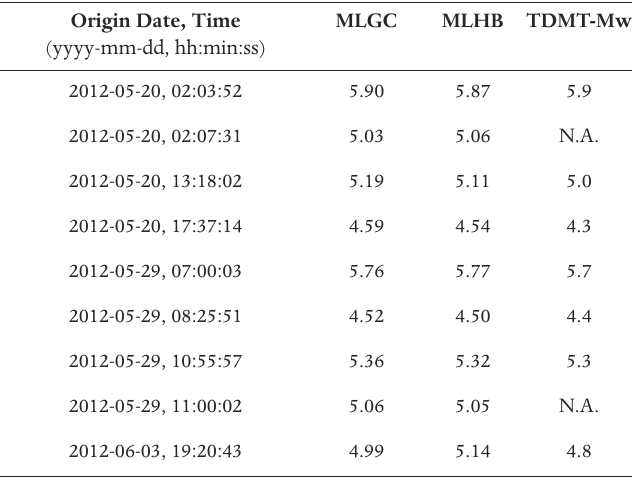
Table 1. Magnitudes of the main earthquakes of the Emilia sequence, com- puted by at least 10 stations (we did not include the M 2012, 03:02:50 UTC, the magnitude of which was computed with less than 10 stations). The reported magnitudes (MLHB) are compared to the val- ues computed in this study (MLGC), and to the M